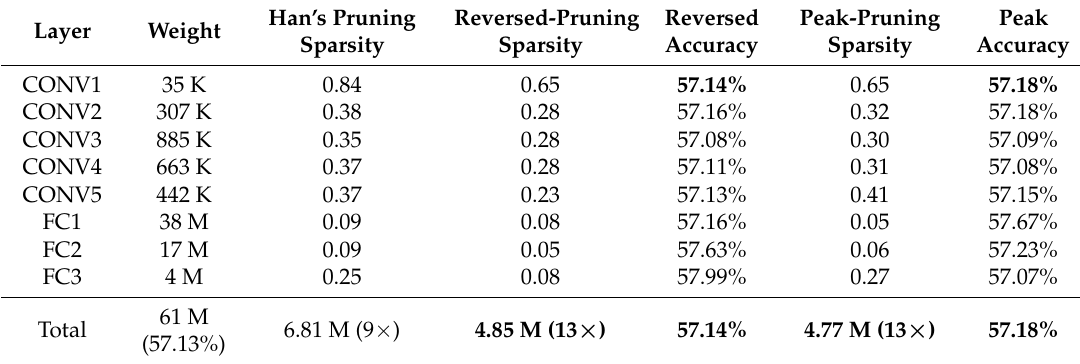
Table 2. For AlexNet, the pruning contrast between Han’s and ours.